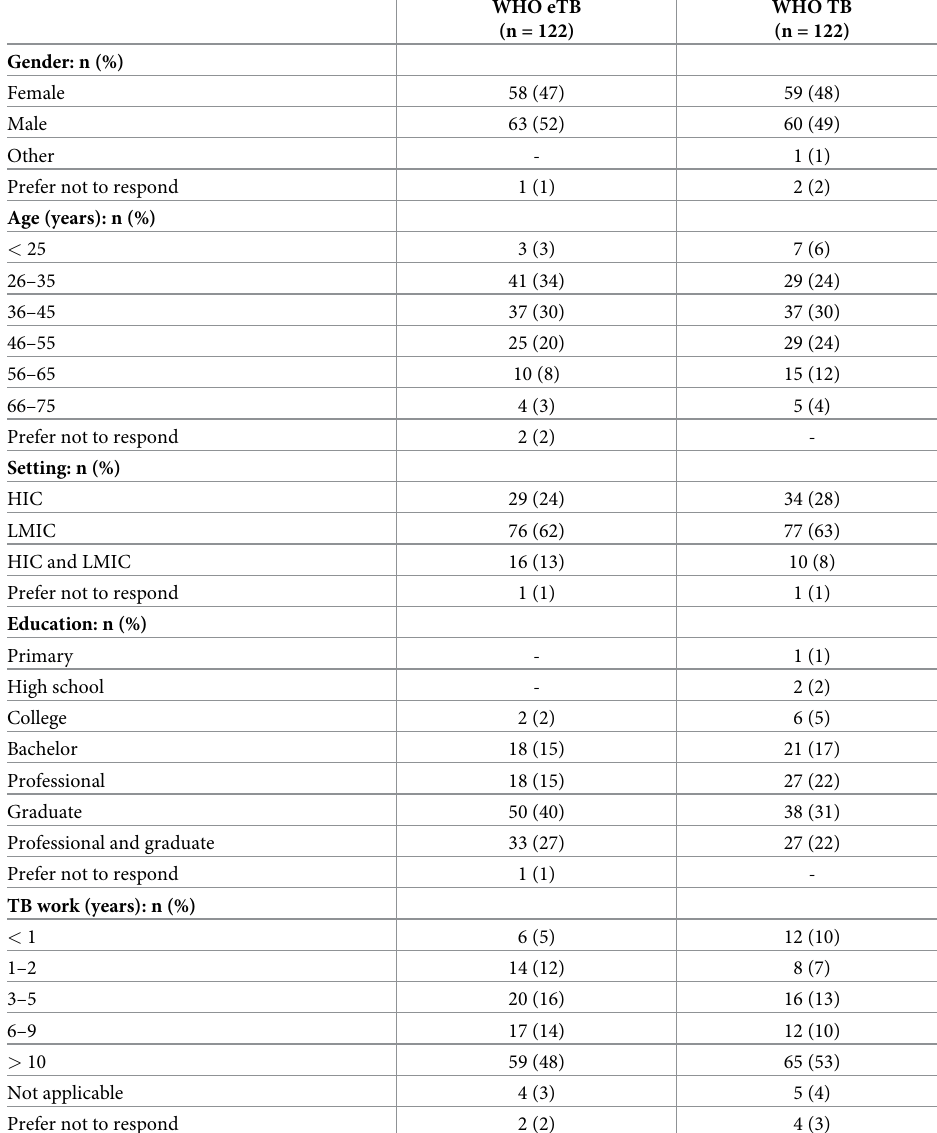
Table 2. Baseline characteristics of participants per